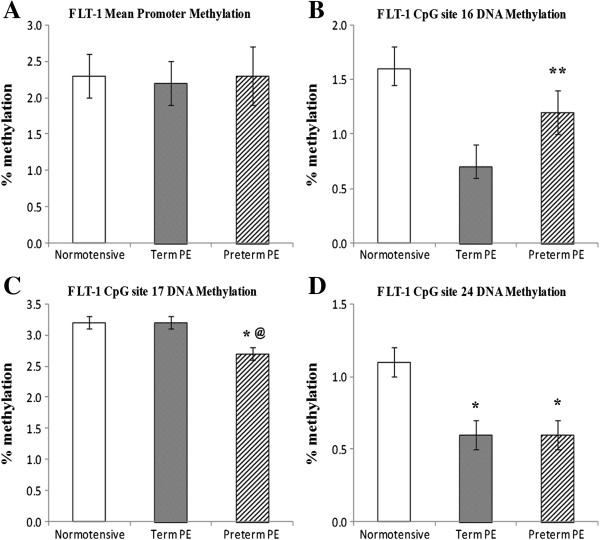
Mean promoter methylation levels and differentially methylated sites in the FLT-1 promoter: (A) FLT-1 Mean Promoter; (B) FLT-1 CpG site 16; (C) FLT-1 CpG site 17; (D) FLT-1 CpG site 24. *P <0.05 and **P <0.01 compared to normotensive group; @P <0.05 compared to the term PE group. PE, preeclampsia.